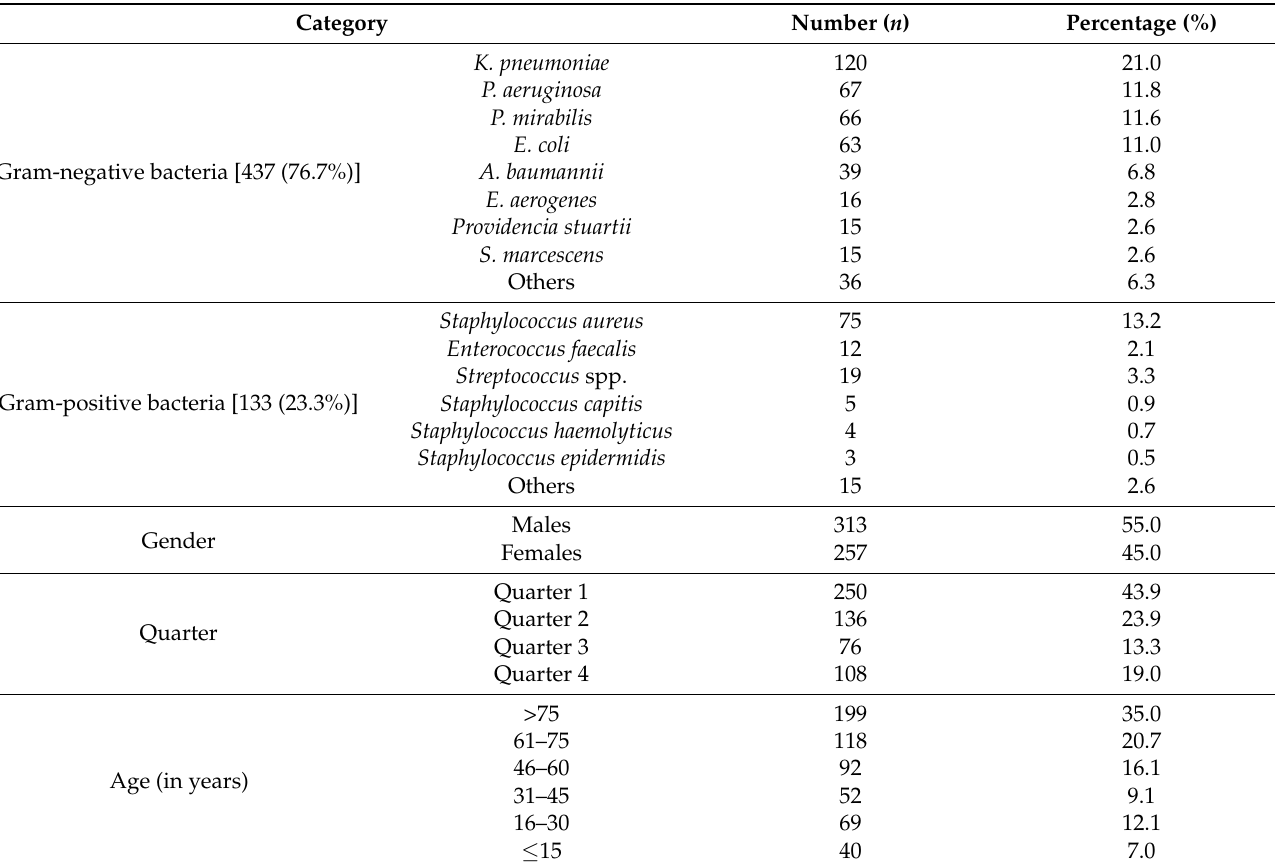
Table 1. Bacteriological diversity and distribution of ICU pathogens ( n =